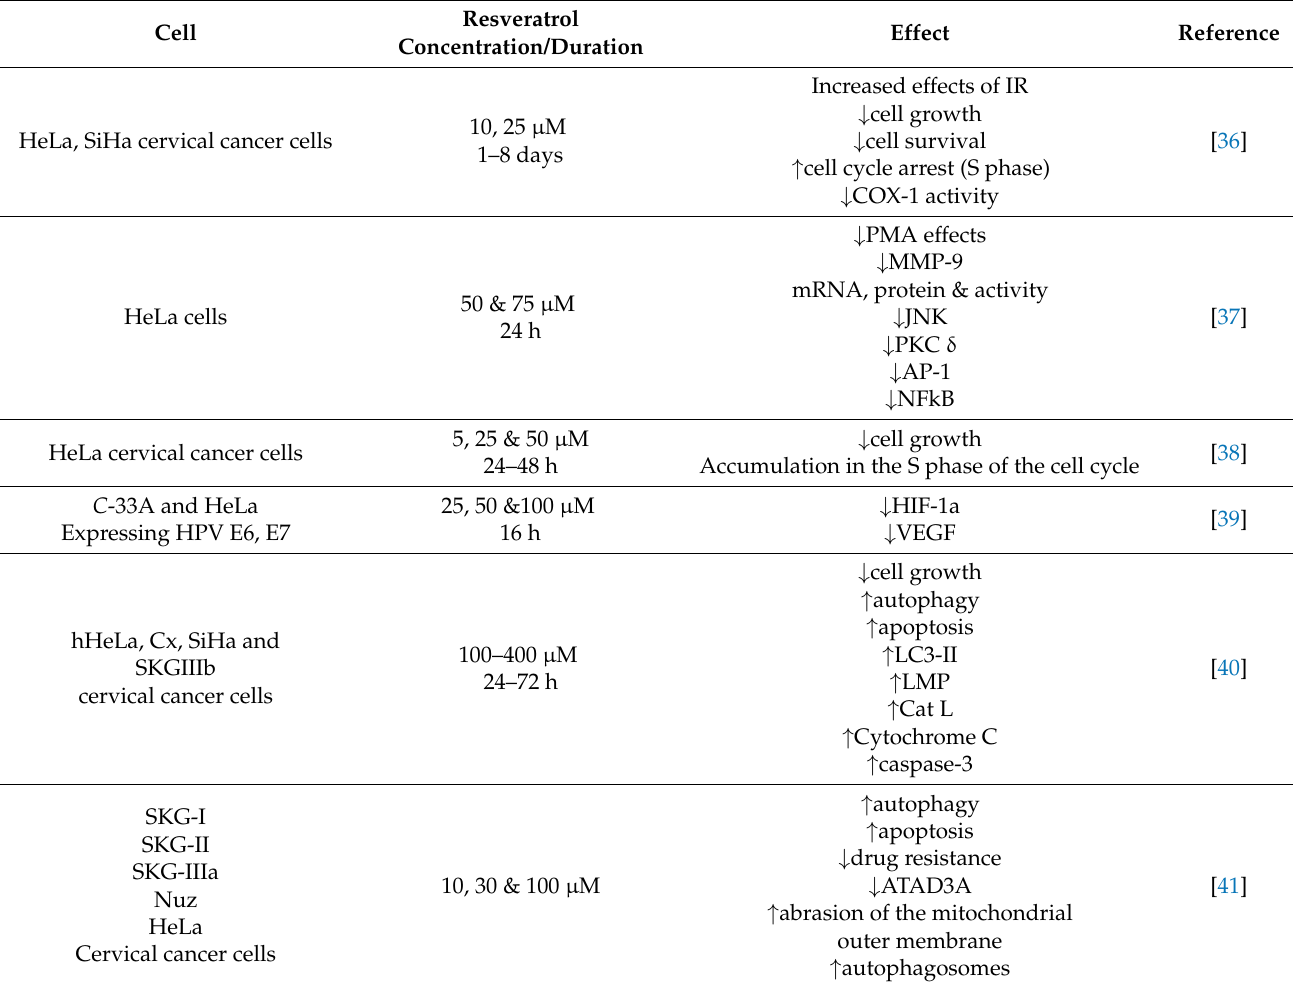
Table 1. Effects of Resveratrol against Cervical Cancer: in vitro studies.